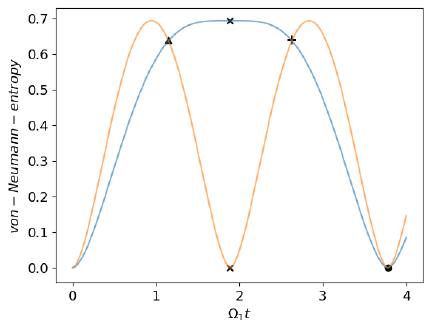
Figure 6. Entanglement propagation for three particles coupled via a single illumination beam as a function of time with d 12 = λ 0 /2 and d 23 = ( 1/2 + 0.1 ) λ 0 for the initial state | 001 (cid:105) . The two curves show the entanglement entropy of the subsystem containing particles 2 and 3 (blue) and the subsystem containing particles 1 and 2 (yellow). So, the blue line describes the entanglement between the subsystem containing particle 1 and the subsystem containing particles 2 and 3, and the yellow line between the subsystem containing particle 3 and the subsystem containing particles 1 and 2. ( (cid:78) ) √ √ corresponds to the state 1/ 3 ( | 001 (cid:105) − i | 010 (cid:105) + i | 100 (cid:105) ) , ( × ) to the state 1/ 2 ( | 01 (cid:105) − | 10 (cid:105) ) | 0 (cid:105) , ( + ) to ( −| 001 (cid:105) + i | 010 (cid:105) − i | 100 (cid:105) ) , and (•) to the state −| 001 (cid:105) the state 1 √ 3